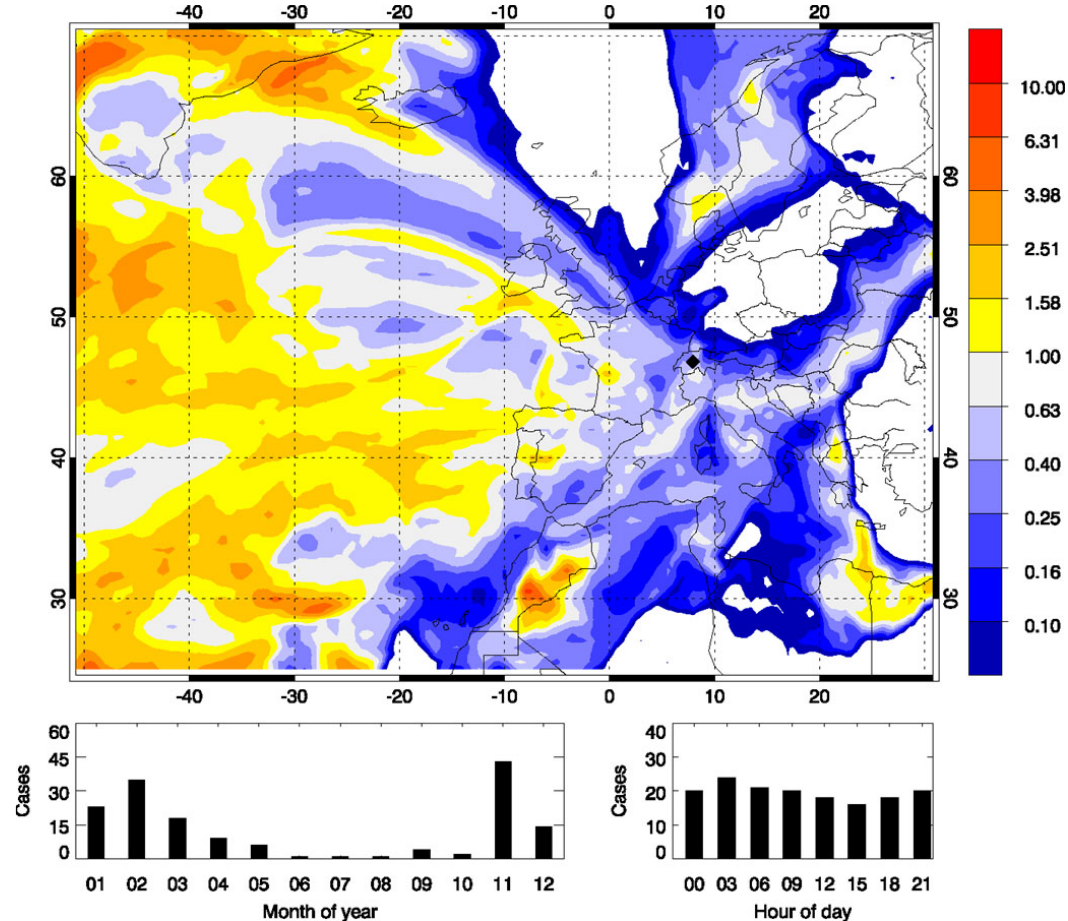
Fig. 14. Relative footprint map associated with high APO and also high O 2 (subset 5). See Fig. 10 for further details.